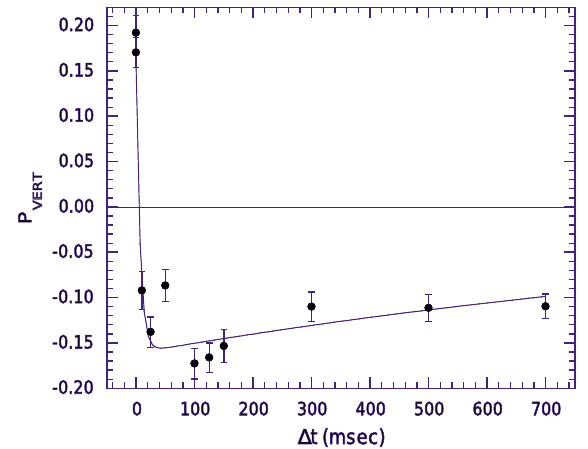
FIG. 4. (Color) The measured vertical proton polarization at 202.7 MeV is plotted against the rf dipole ramp time D t . The frequency range D f was 4 kHz and the rf dipole’s 0.06 T mm. The curve is hand drawn to guide the eye.